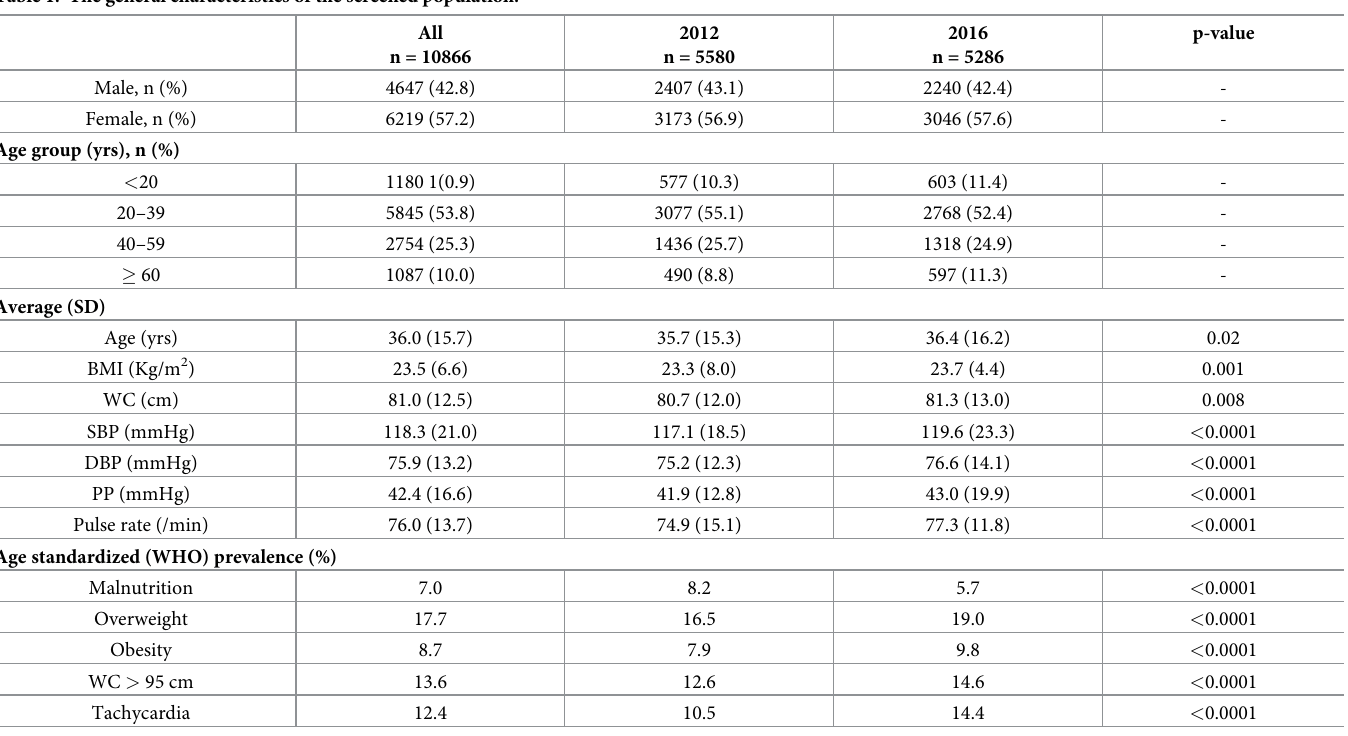
Table 1. The general characteristics of the screened